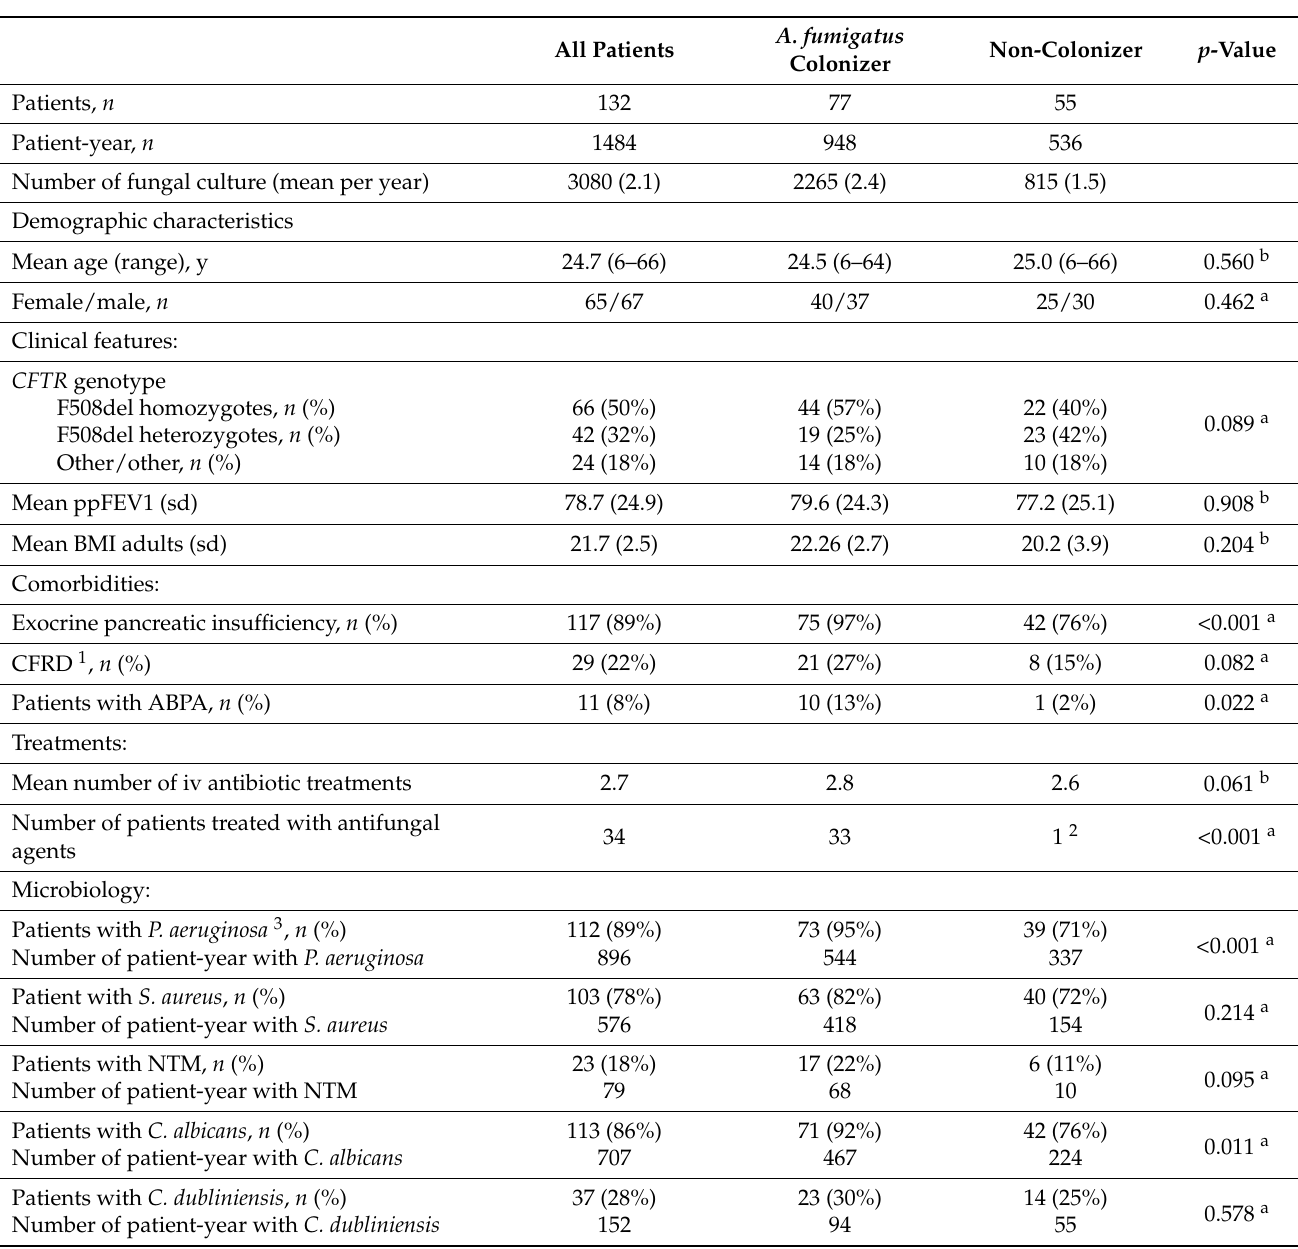
Table 1. Patient